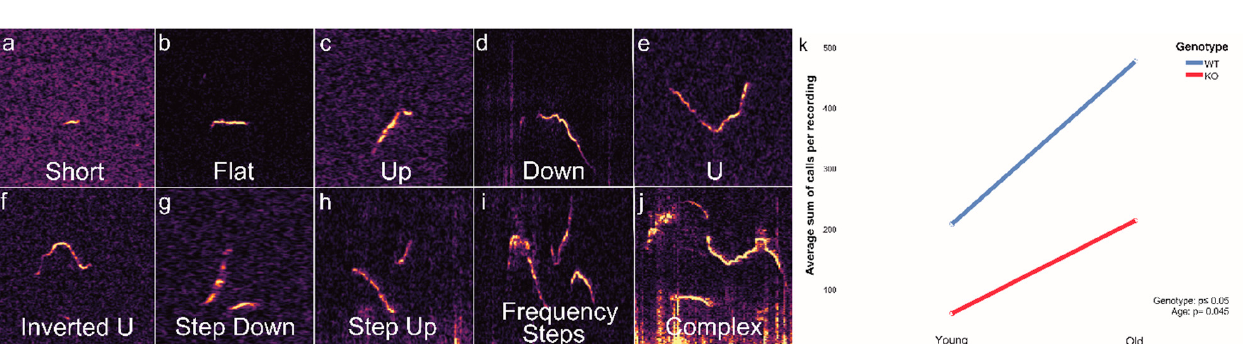
Figure 1. Subdivision of the ten different call types and their percentage distribution. ( a – j ) Examples of calls, generated by DeepSqueak. ( a ) Short. ( b ) Flat. ( c ) Up. ( d ) Down. ( e ) U. ( f ) Inverted U. ( g ) Step Down. ( h ) Step Up. ( i ) Frequency Steps. ( j ) Complex. ( k ) Total number of calls: two-way ANOVA demonstrating the averaged sum of calls per five-minute recording of young and old animals from WT and KO (WT Young n = 1658 ± 214, WT Old n = 3326 ± 358, KO Young n = 238 ± 40, KO Old n = 1271 ± 142; genotype p ≤ 0.05; age p = 0.045).